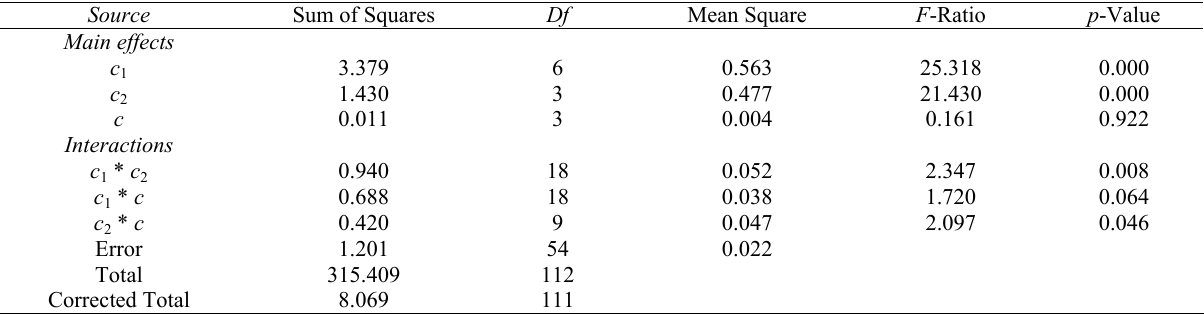
Table 1. ANOVA table for the experiment on tuning the parameters of DABC Source Sum of